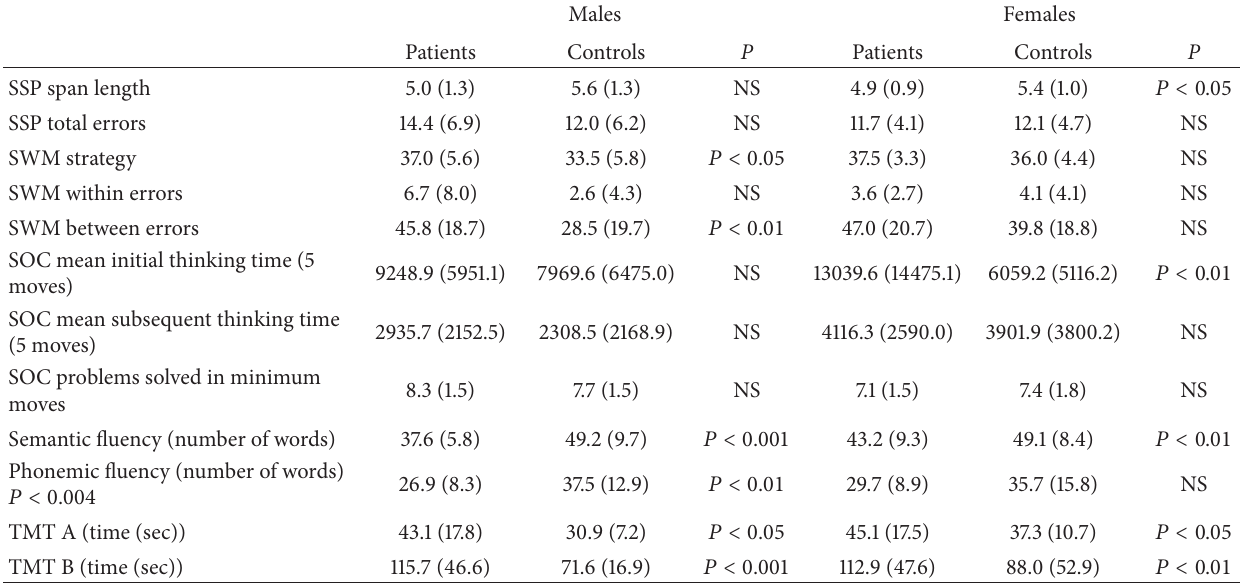
Table 4: Male-only and female-only comparisons of cognitive functions (values expressed as means and standard deviations shown in